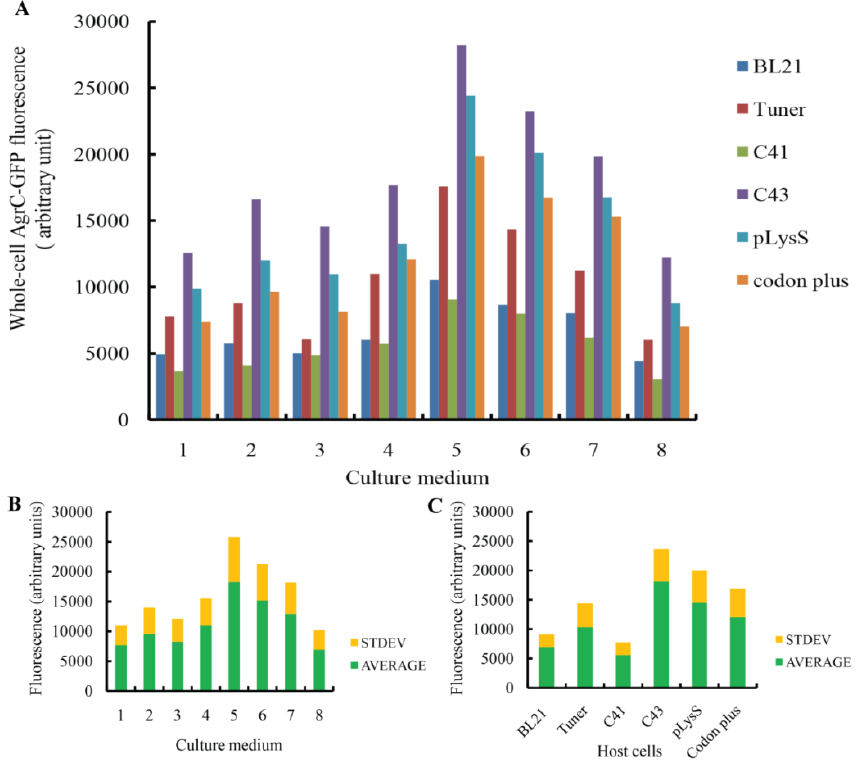
( C ) Statistical significance of the fluorescence counts for each of the eight types of media. The green bars indicate average values and the yellow regions correspond to standard